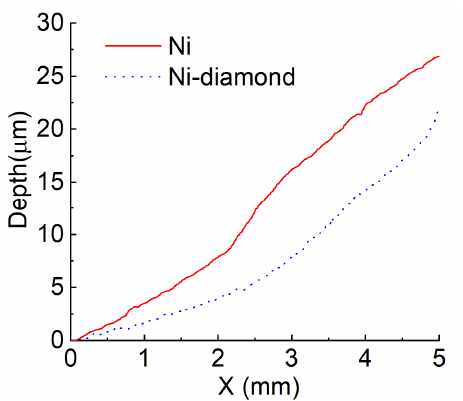
Figure 6. The end scratch depths for the Ni coating and the Ni–diamond coating .